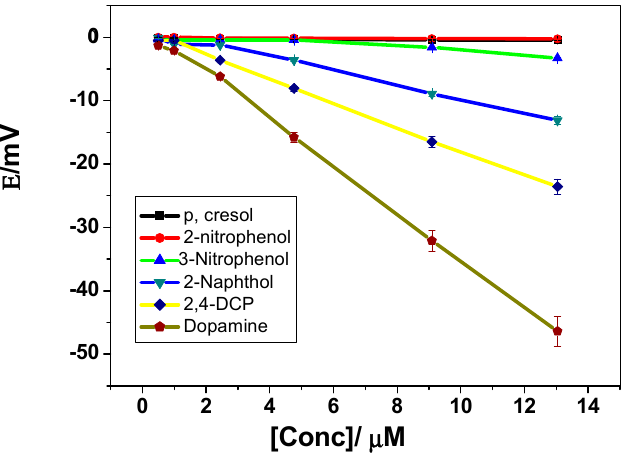
Figure 8. Potentiometric selectivity of MIP membrane-based sensors towards dopamine.